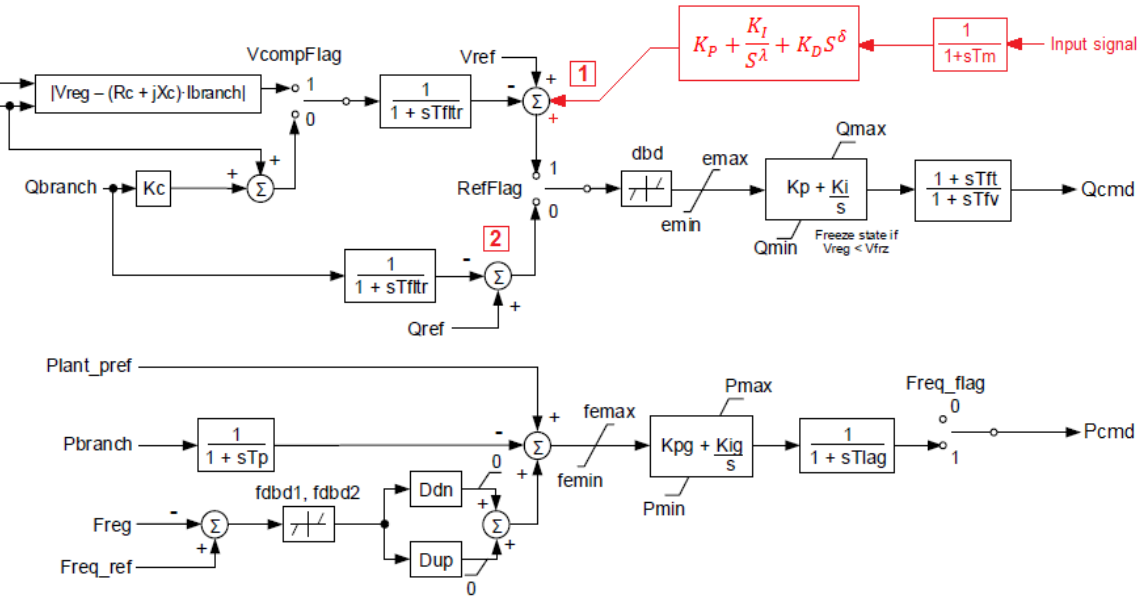
Figure 9. Block diagram of an REPC_B module of an LPF dynamic model with the FOPID controller.